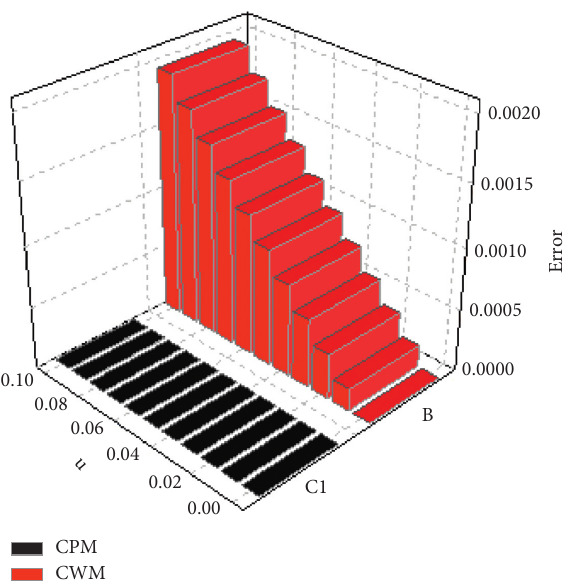
Figure 2: Error graph of CWM and CPM for problem 1.